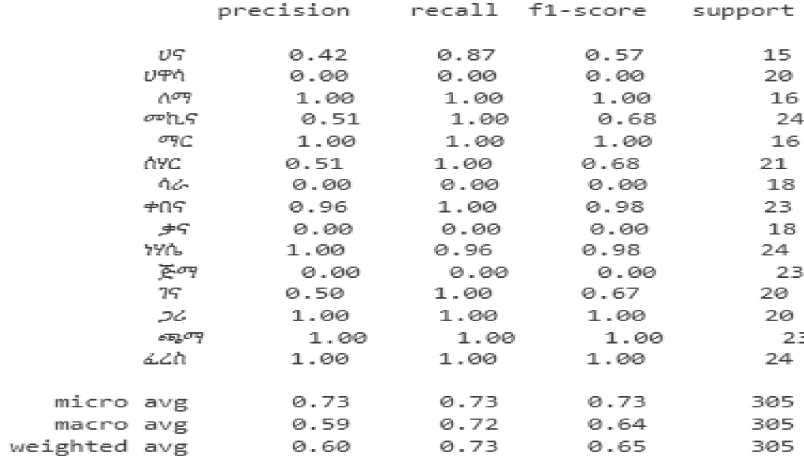
Figure 13: Performance metrics for the developed model.